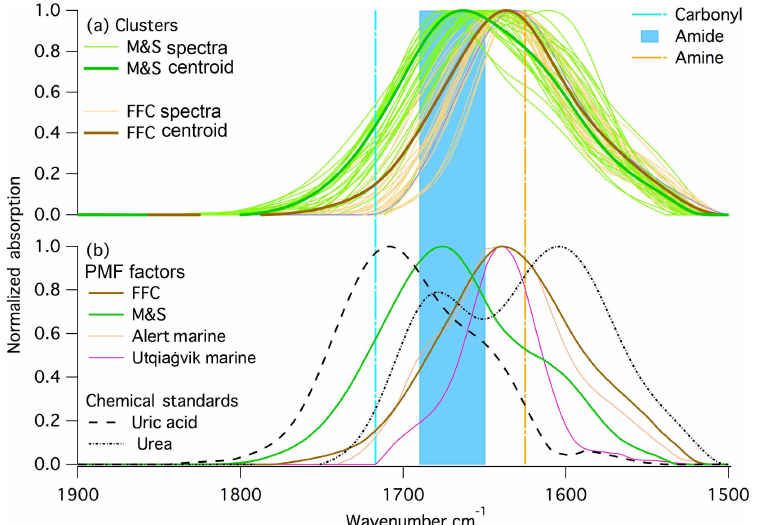
Figure 5. Normalized spectra at 1500 to 1800cm − 1 wavenumber region from (a) k -mean clustering centroid and spectra in the clusters; (b) PMF factors from this study and two previous arctic studies, and chemical standards: urea and uric acid. Locations of primary amine and carbonyl group are marked on the